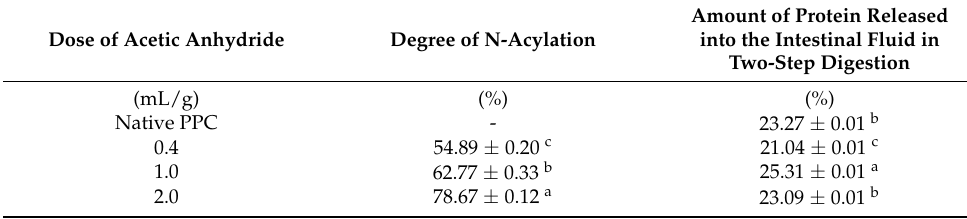
Table 3. Degree of N-acetylation and in vitro digestibility of native and acetylated PPC. Dose of Acetic Anhydride Degree of N-Acylation